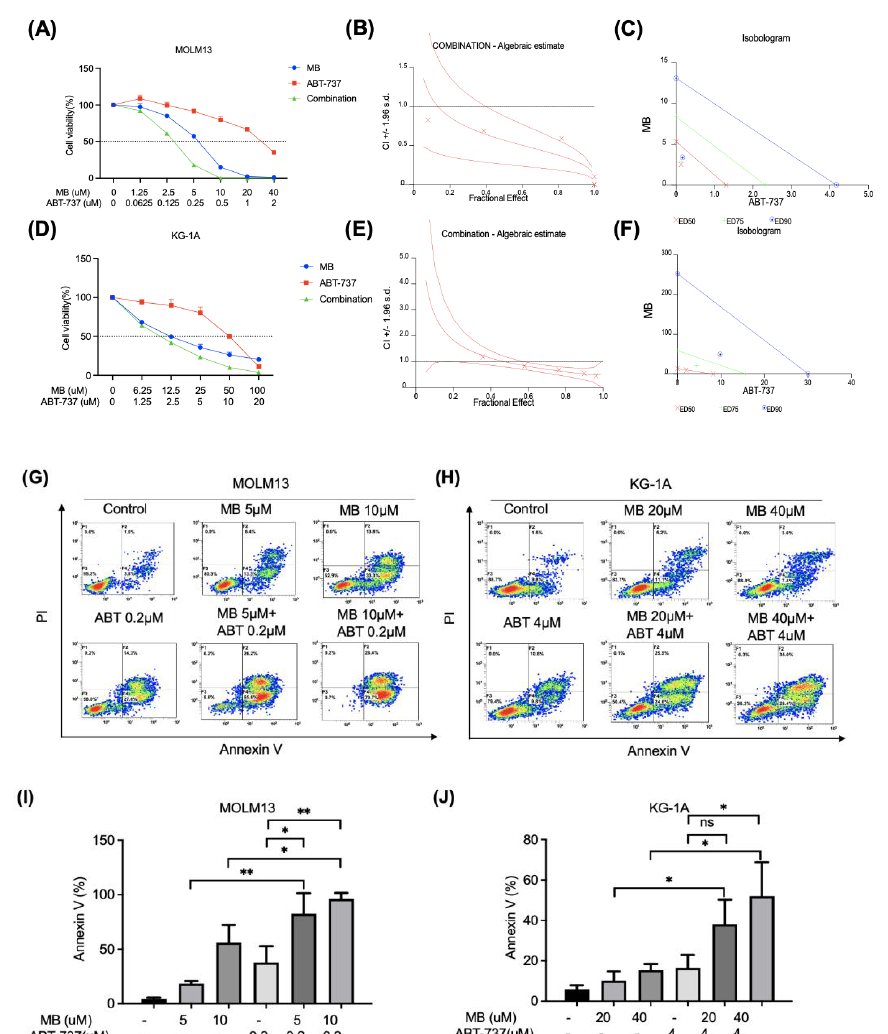
Figure 5 . Treatment with a combination of MB and the BCL-2 inhibitor ABT-737 resulted in synergistic inhibition of AML cell growth. ( A , D ) AML cells were treated with different doses of MB or ABT-737 or their combination for 72 h and analysed with MTT assays. ( B , E ) The effects of the combination treatment were assessed using the CalcuSyn program. For the Fractional Effect-Combination Index plots, the Y-axis represents the combination index (CI), and the X-axis represents the magnitude of effect (maximum 1.0). The middle line represents a plot of the data and the other two lines show the confidence intervals. CI <1 indicates a synergistic effect, CI = 1.0 indicates an additive effect, and CI >1 indicates an antagonistic effect. ( C , F ) For the isobologram plots, the three diagonal straight lines connecting the ED50, ED75, and ED90 of MB and ABT-737 represent the theoretical lines of additivity for a continuum of different fixed dose ratios. The three single points representing the combinations at ED50, ED75, and ED90 under their respective diagonal straight lines denote synergism. ( G – J ) AML cells were treated with different doses of MB for 48 h and then analysed for apoptosis using FCM (PI and Annexin V method). Results from the quantitative analysis of the percent of apoptotic cells (Annexin V+) are shown in bar blots. Error bars represent SD. * p < 0.05, ** p < 0.005 compared to the single agent group.